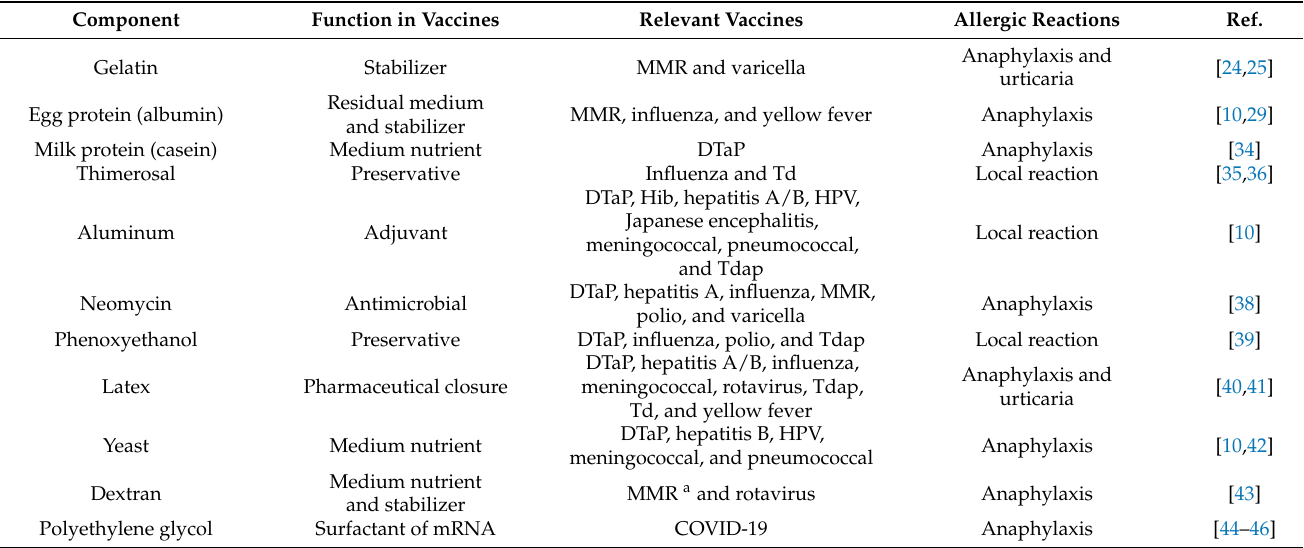
Table 2. Immediate component-mediated reactions and associated vaccines in